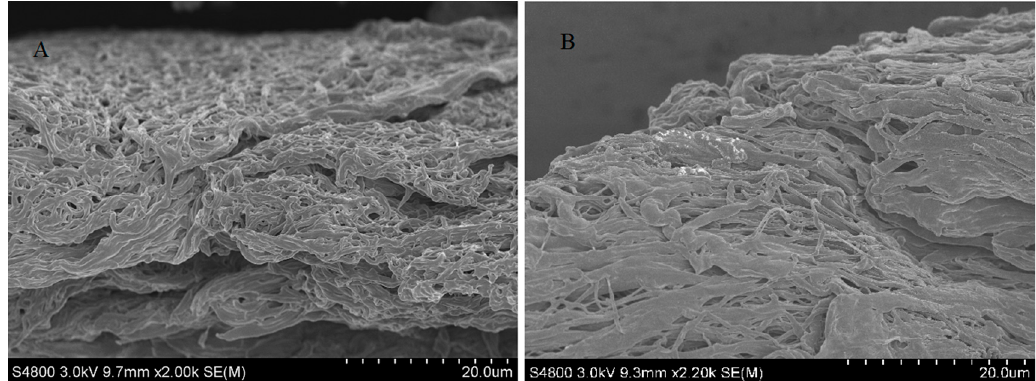
Figure 6. SEM images of the broken edge of the electrospun nanofibers mat of P1 (A) and P2 (B) after stretching in mechanical test.